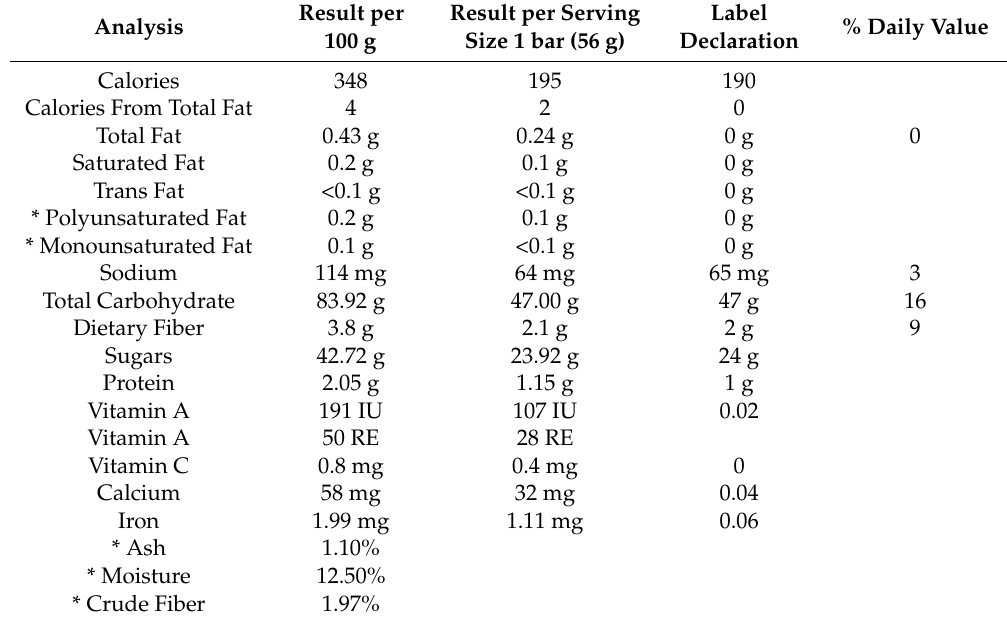
Table 2. Nutritional label